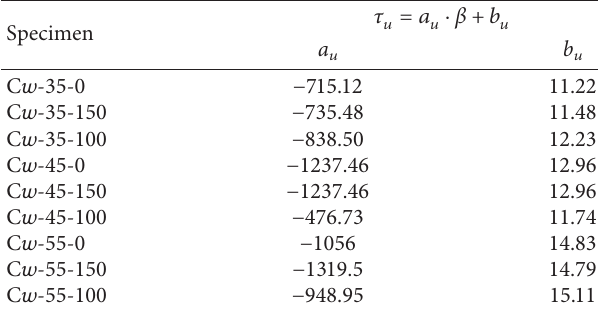
Table 8: The expression of the ultimate bonding strength and nonlinear coefficient β .